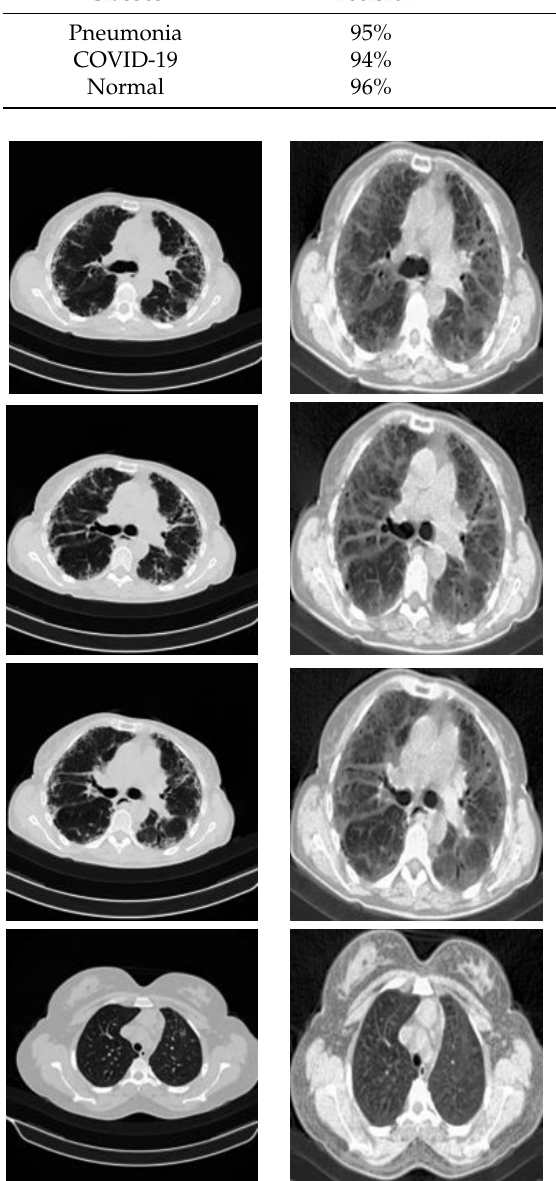
Figure 7. Preprocessing of Cheikh Zaid data. ( Left ) Before preprocessing. ( Right ) After